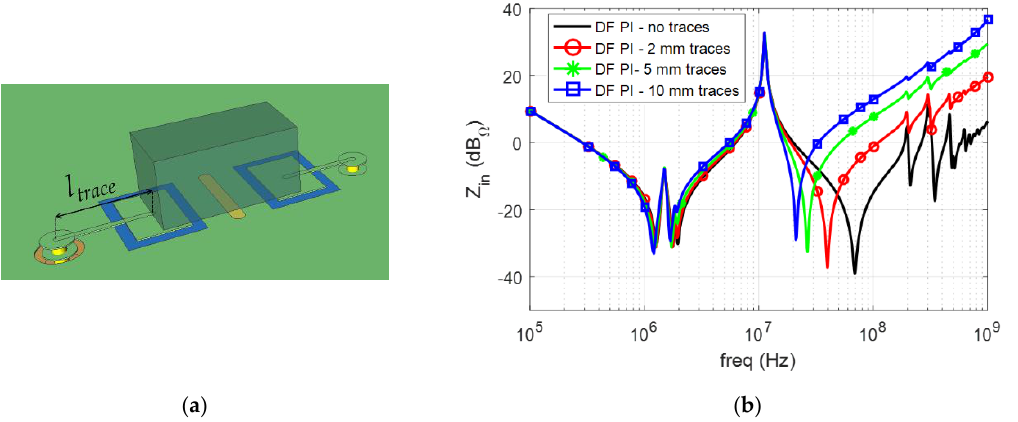
Figure 4. ( a ) Trace, whose length is l trace , connecting the port to the vias and ( b ) Z in computed by DF PI when the l trace is changed from 0 to 10 mm.